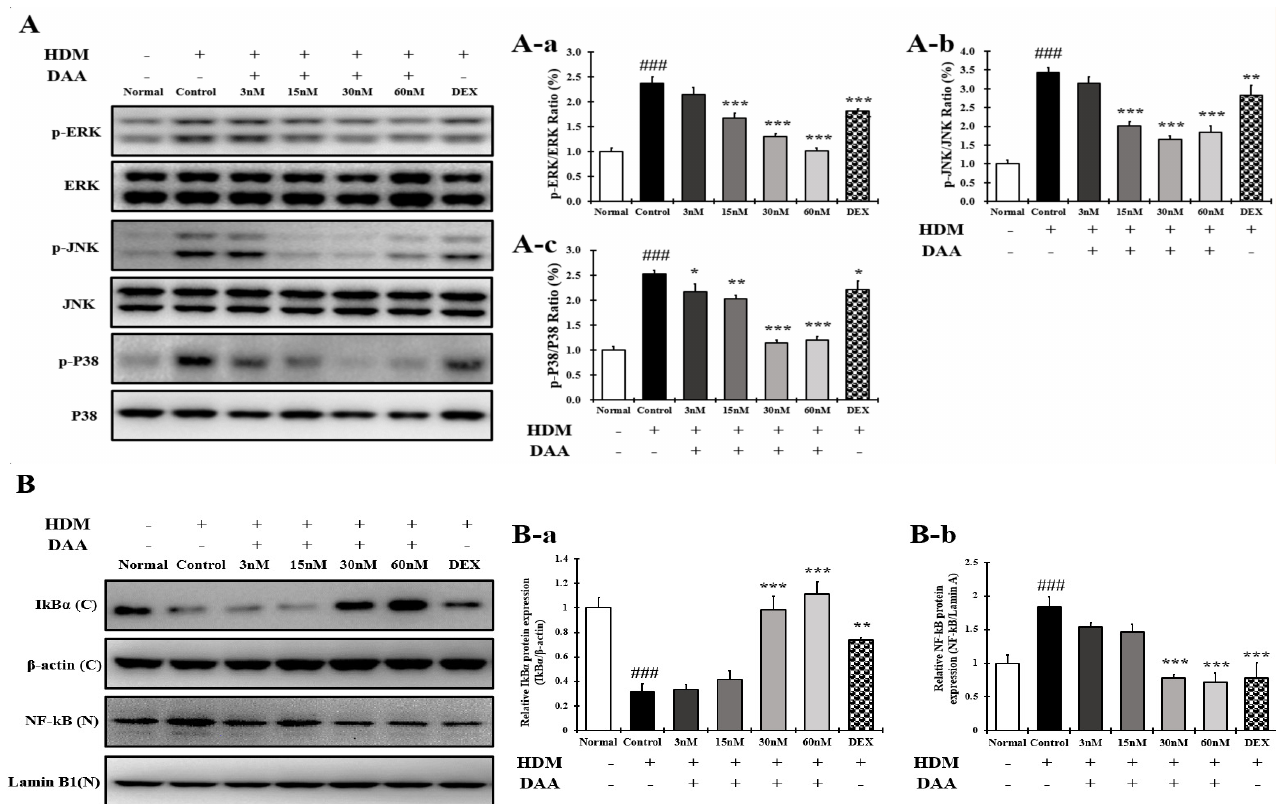
Figure 16. Effect of DAA on MAPK phosphorylation and NF-kB activation in EOL-1 cells. ( A ) DAA inhibited the phosphorylation of MAPK (ERK, JNK, and P38) in EOL-1 cells ( A-a , A-b , A-c ). ( B ) DAA also inhibited the degradation of IkB α and the translocation of NF-kB into the nucleus ( B-a , B-b ). I κ B α was normalized to β -actin and NF-kB was normalized to Lamin B1. The results are expressed as the mean ± SD (n = 4). ### p < 0.001 vs. normal; * p < 0.05, ** p < 0.01, and *** p < 0.001 vs. control. DAA was used at 3 nM, 15 nM, 30 nM, and 60 nM. DEX, the positive control, was used at 2 nM.